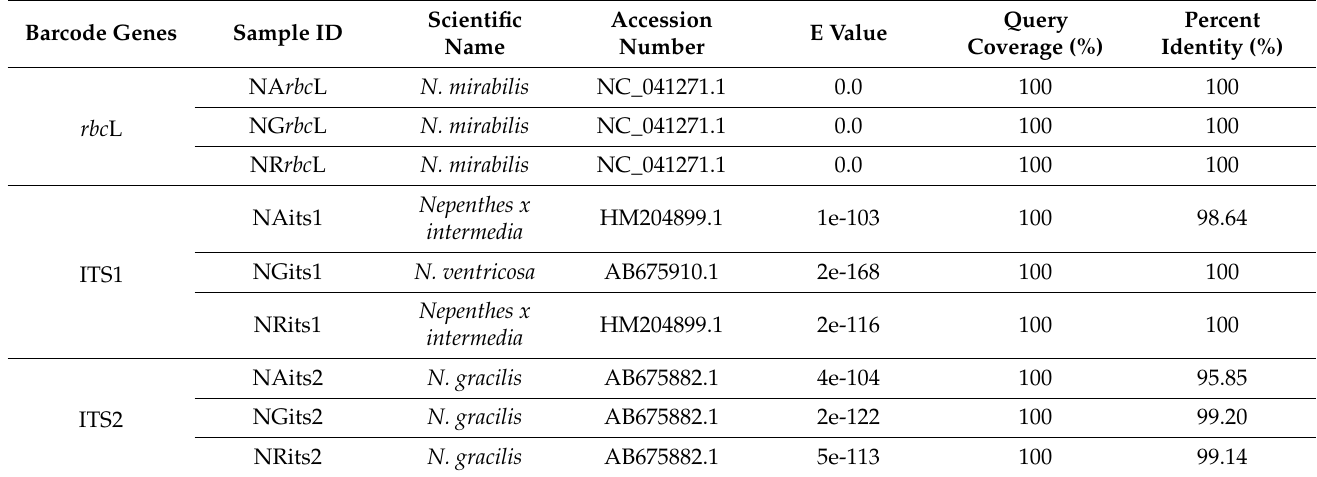
Table 4. Molecular identification of Nepenthes species using rbc L, ITS1 and ITS2 barcode genes.